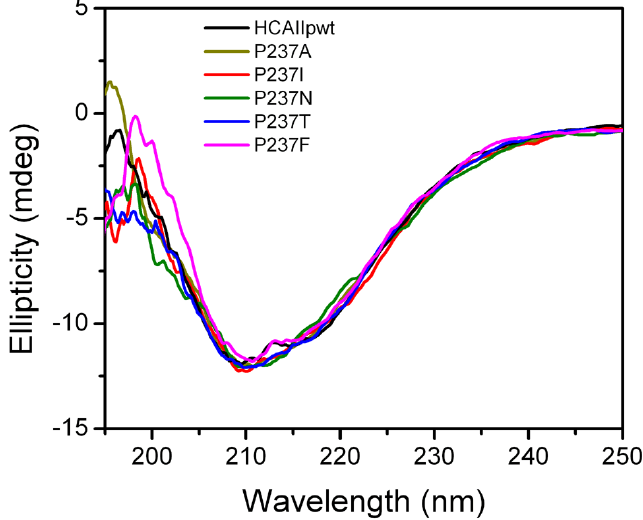
and the mutants. pwt